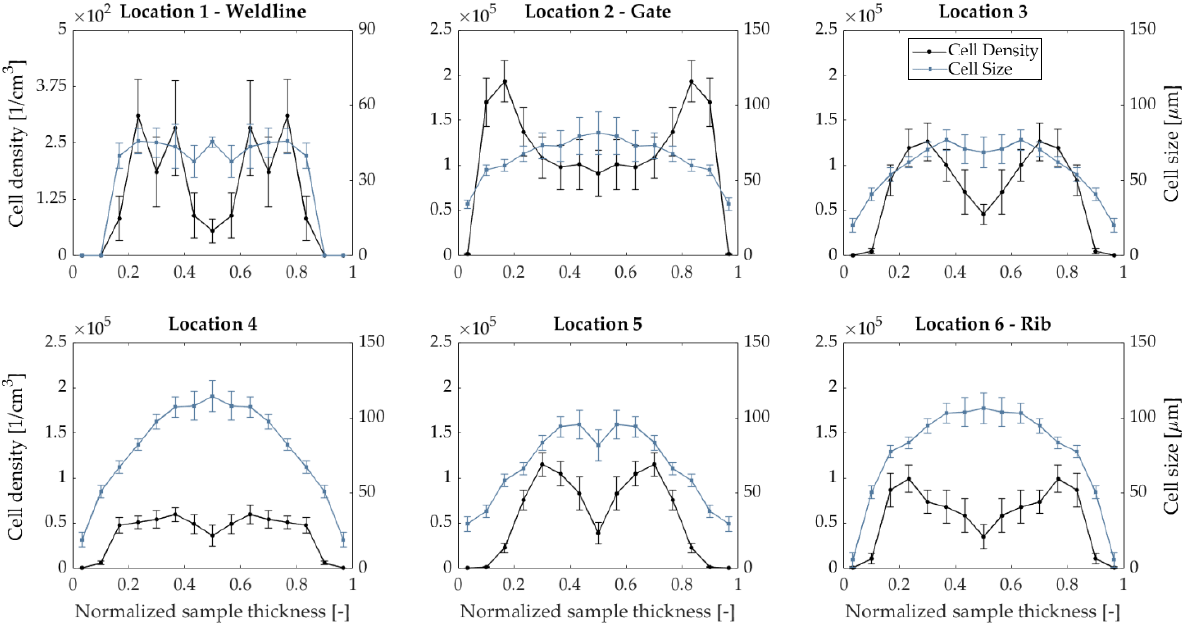
Figure 8. Cell density and cell size across the part thickness for compact and foamed door panels.